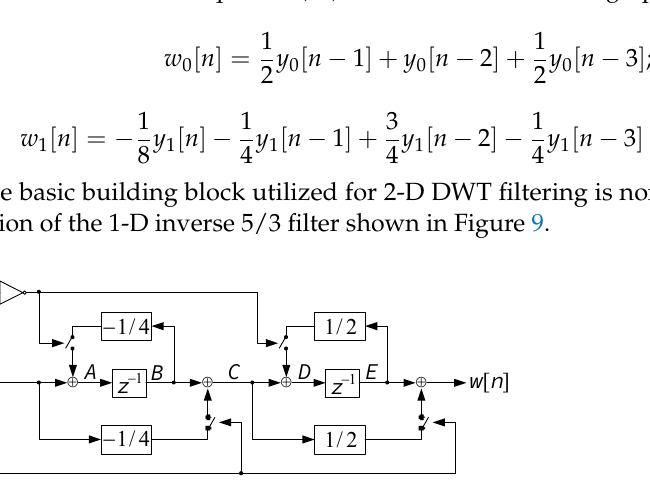
Figure 9. Non-stationary hardware realization of the 1-D inverse 5/3 Figure 9. Non ‐ stationary hardware realization of the 1 ‐ D inverse 5/3 filter.